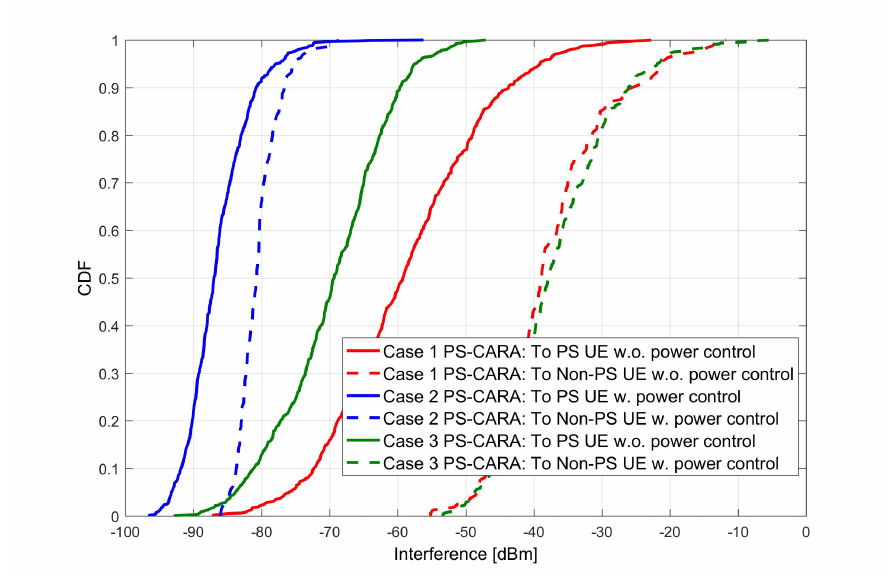
Figure 8. PS and non-PS users’ individual interference under the proposed PS-CARA scheme.